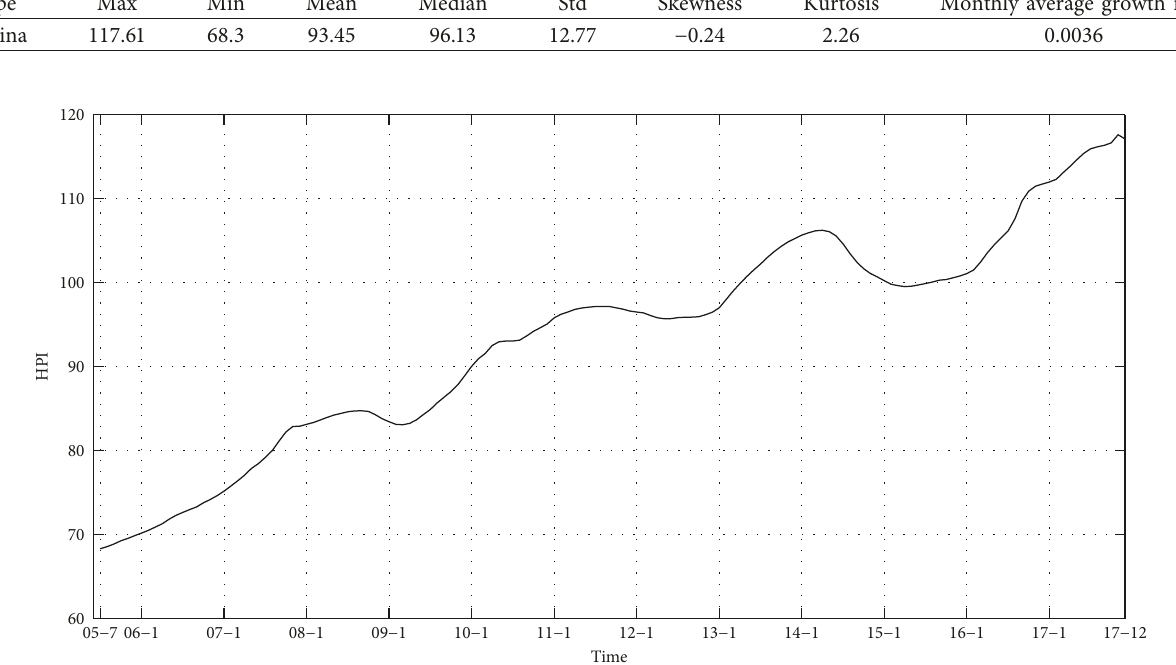
Figure 1: HPI trend of the overall real estate